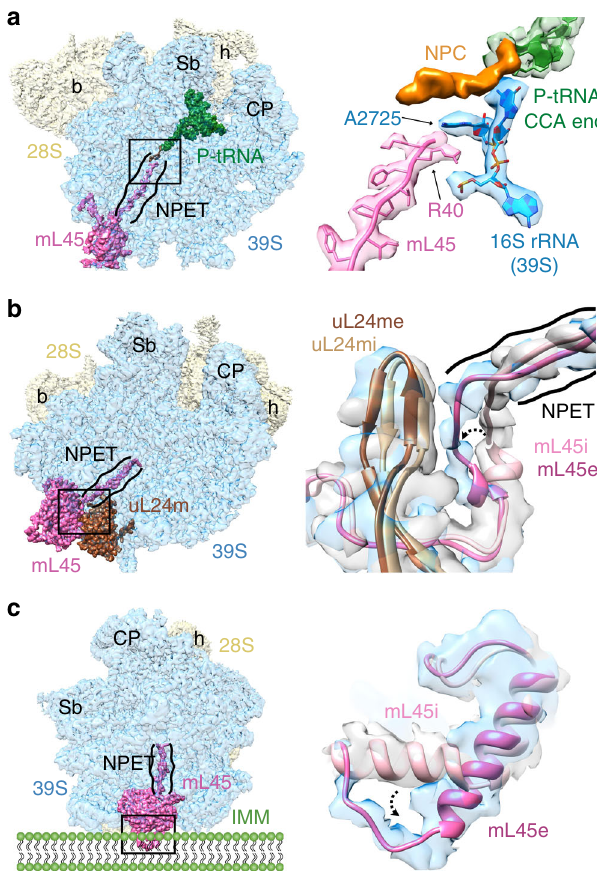
Fig. 6 Location of the nascent polypeptide chain and conformational changes in mL45 between the initiation and elongation complexes. a A density linked to the CCA end of the P-site tRNA (green) was identi fi ed as NPC (orange) that approaches the N-terminus (NT) of ribosomal protein mL45 (pink). A2725 from the 16S LSU rRNA (blue) is positioned between the NT of mL45 and the nascent polypeptide chain (NPC). b The N terminus region (R61-D73) of mL45 in the elongation complex (mL45e, deep pink) has shifted substantially toward uL24m, as compared to its position in the initiation complex (mL45i, light pink) 9 . The shift in mL45 is accompanied by a small movement in uL24m between the initiation (uL24i, light brown) and elongation (uL24e, dark brown) states. c Conformational change in the core region of mL45. Curved arrows in panels b and c point to observed movements from initiation to elongation complexes. Thumbnails in panel a , b , and c depict the overall orientation of the 55S mitoribosome where the 28S SSU (semitransparent yellow) is placed behind the 39S LSU (semitransparent blue), with relevant MRPs highlighted. Landmarks on the thumbnails are as in Fig. 4. Depiction of inner mitochondrial membrane (IMM) in panel c provides context to the location of the observed conformational lipid content of the IMM through charge-based interactions 61 , which could be accompanied by the observed conformational change in this study. Furthermore, the C-terminal region of the uL23m that interacts with the mL45 NT has undergone a large conformational change where its α -helix involving aa residues A123-R137 has moved by ~20 Å toward the mL45 NTE. It appears that this α -helix movement is necessary to clear the path for the displacement of mL45 ’ s NTE from the exit tunnel (Supplementary Fig. 11a). However, a comparison of the sequences of uL23m in human with other mammals (Supple- mentary Fig. 11b) suggests that this major conformational difference could be species-speci fi c.